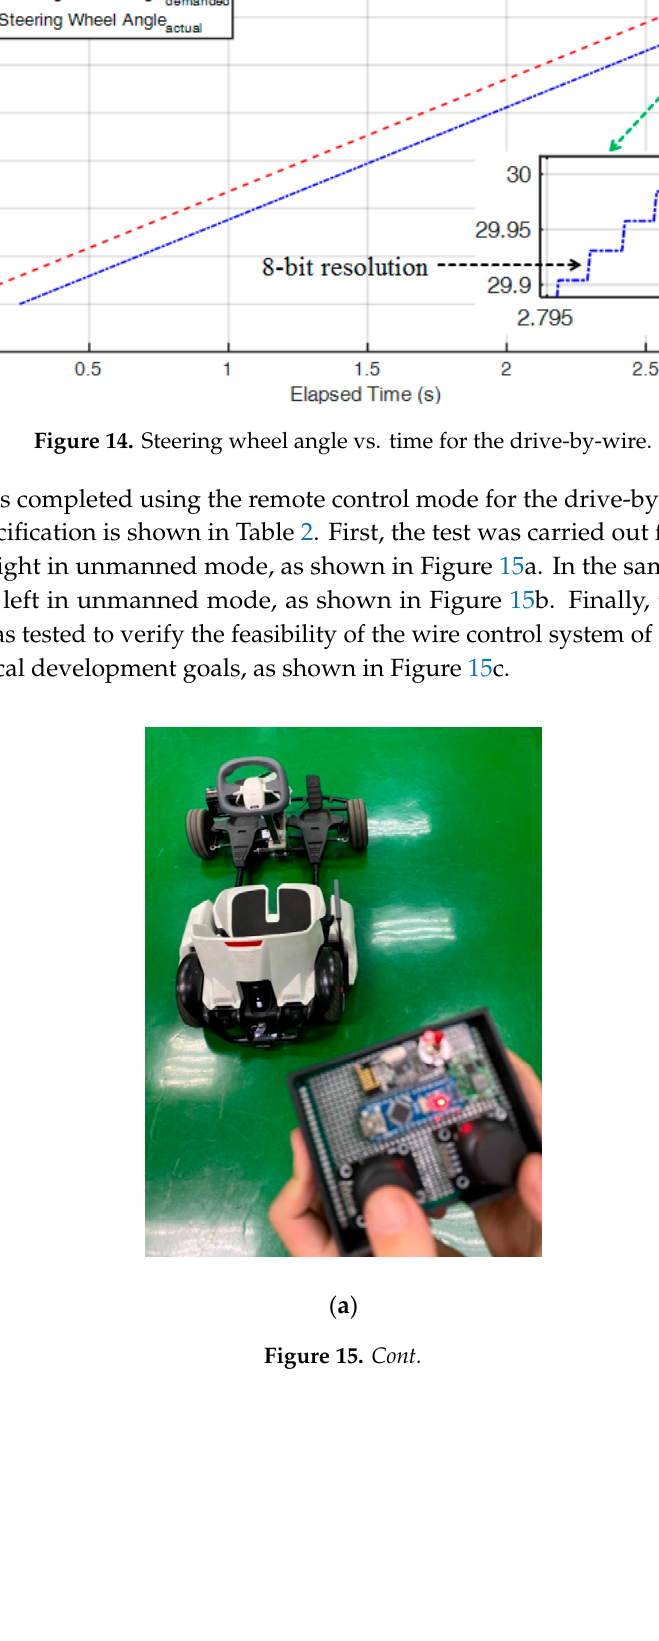
Figure 13. ( a ) Accelerator voltage vs. time for the drive-by-wire; ( b ) brake pedal voltage vs. time for the drive-by-wire.